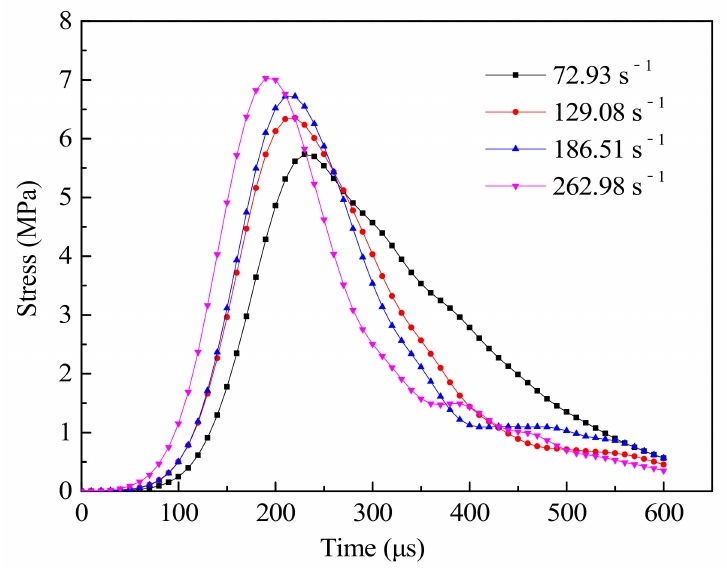
Figure 9. Tensile stress history